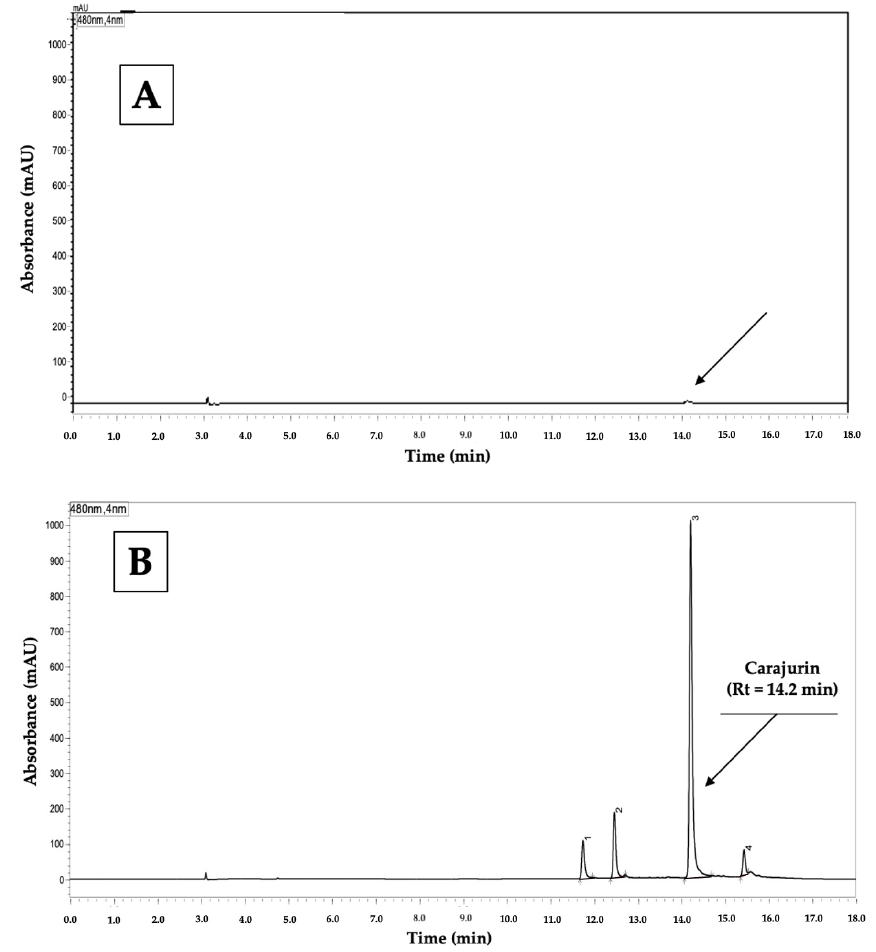
Figure 3. ( A ) Chromatogram for the analysis of the diluent (ACN:MeOH, 75:25, v / v ) at 480 nm. A small peak observed in the carajurin chromatographic window is due to carryover, but it is closer the LDQ (black arrow). ( B ) Chromatogram for the analysis of the Arrabidaea chica hydroalcoholic extract (ACHE) at 480 nm.